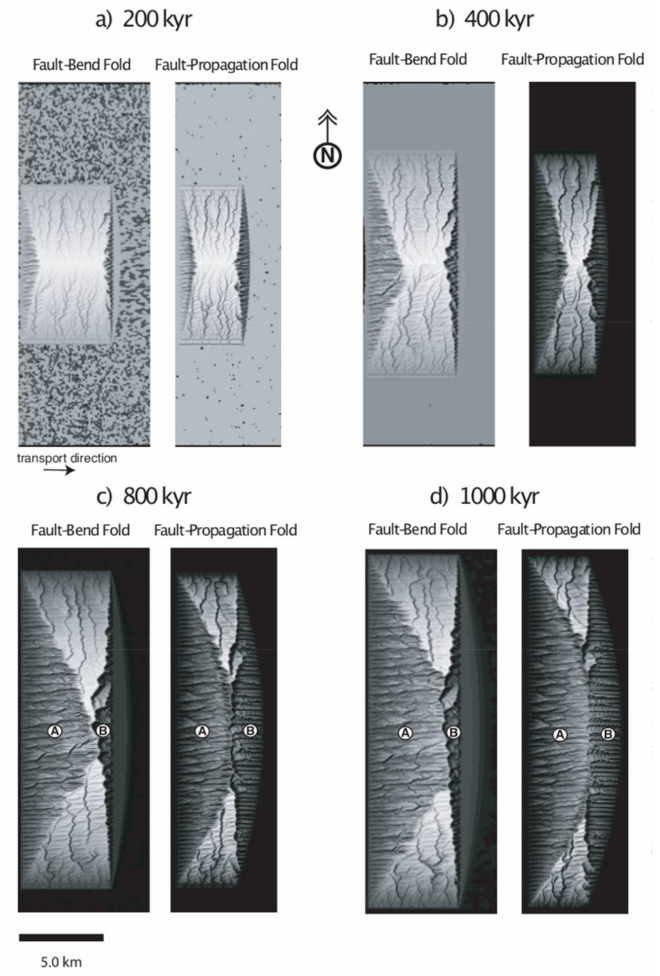
Figure 11. Evolution of the fault-propagation and fault-bend fold models under conditions of lateral propagation, power law D/L relation, and constant slip distribution. ( a ) 200 kyr, ( b ) 400 kyr, ( c ) 800 kyr and ( d ) 1000 kyr. Greyscale shaded relief images with illumination from NW, azimuth is 30 degrees. A and B are drainage basins discussed in